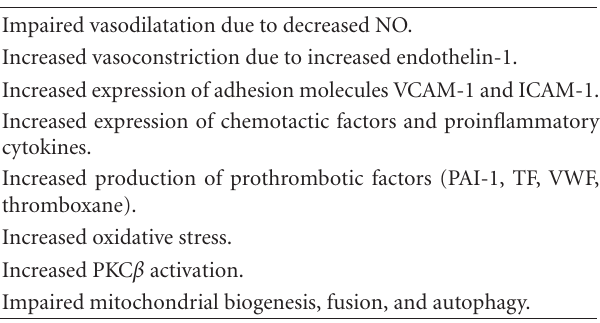
Table 1: Endothelial dysfunction in diabetes mellitus. Impaired vasodilatation due to decreased NO. Increased vasoconstriction due to increased endothelin-1. Increased expression of adhesion molecules VCAM-1 and ICAM-1. Increased expression of chemotactic factors and proinflammatory